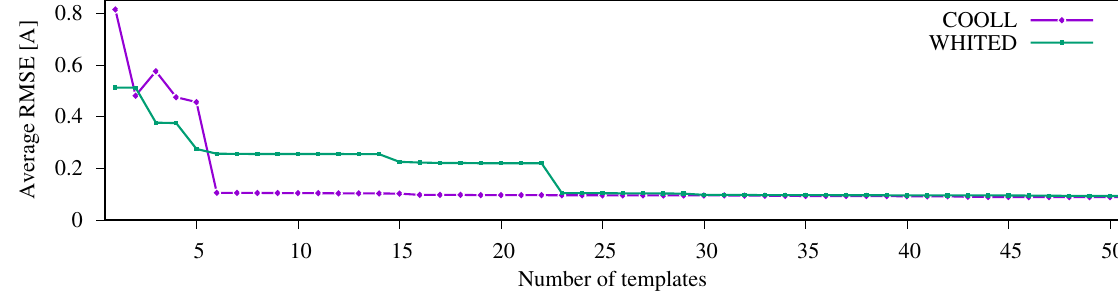
Figure 9. Resulting averaged RMSE versus the number of output clusters for the considered data